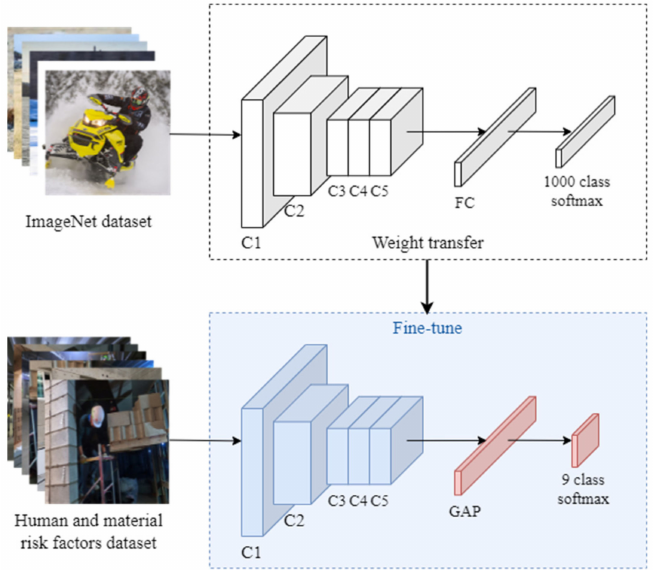
Figure 2. Architecture of risk factor recognition